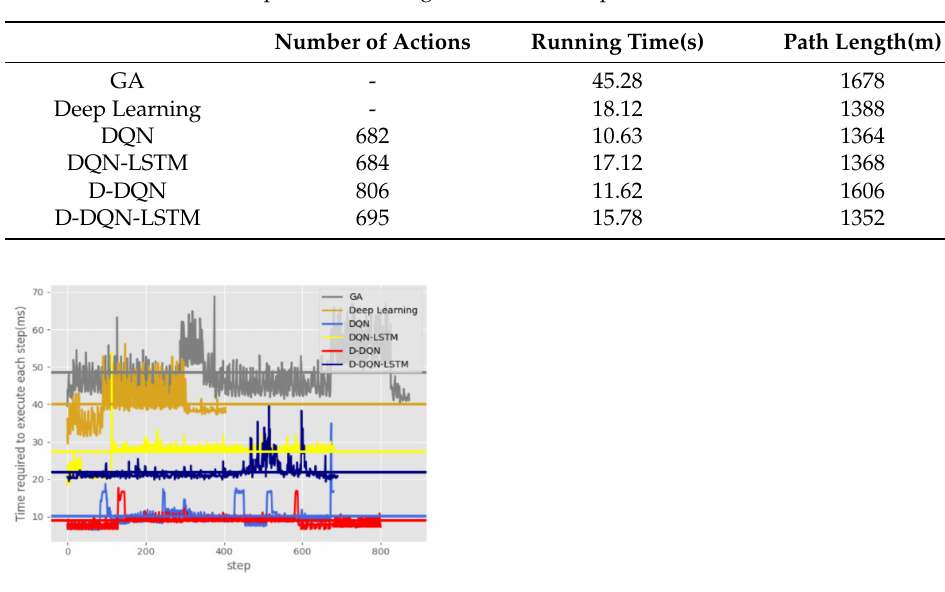
Table 5. Performance comparison of six algorithms in a complicated environment.